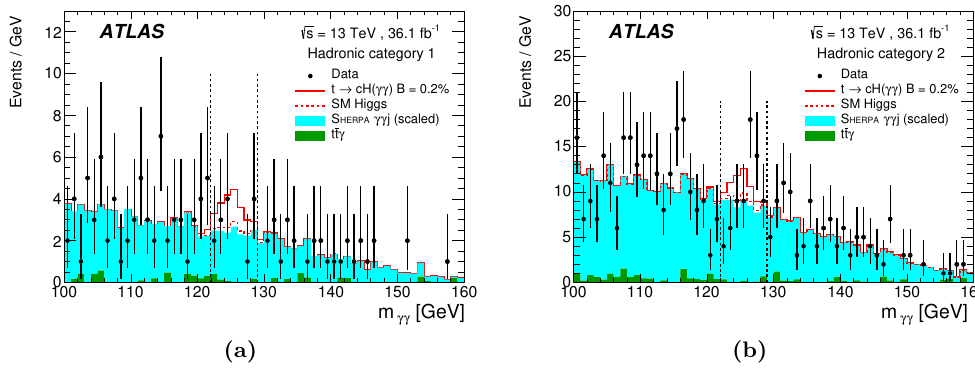
Figure 2. Distributions of the diphoton invariant mass, for data events, the t (cid:22) t(cid:13) sample, and the S (cid:13)(cid:13)j sample for (a) category 1 and (b) category 2 of the hadronic selection. The t (cid:22) t(cid:13) sample is normalised using the data’s integrated luminosity and the theoretical cross section. The Sherpa S (cid:13)(cid:13)j sample is normalised to the di(cid:11)erence between data and t (cid:22) t(cid:13) . The SM Higgs boson production and an additional FCNC signal normalised assuming B = 0 : 2% are shown stacked over the sum of the backgrounds. The vertical dotted lines indicate the signal region (see